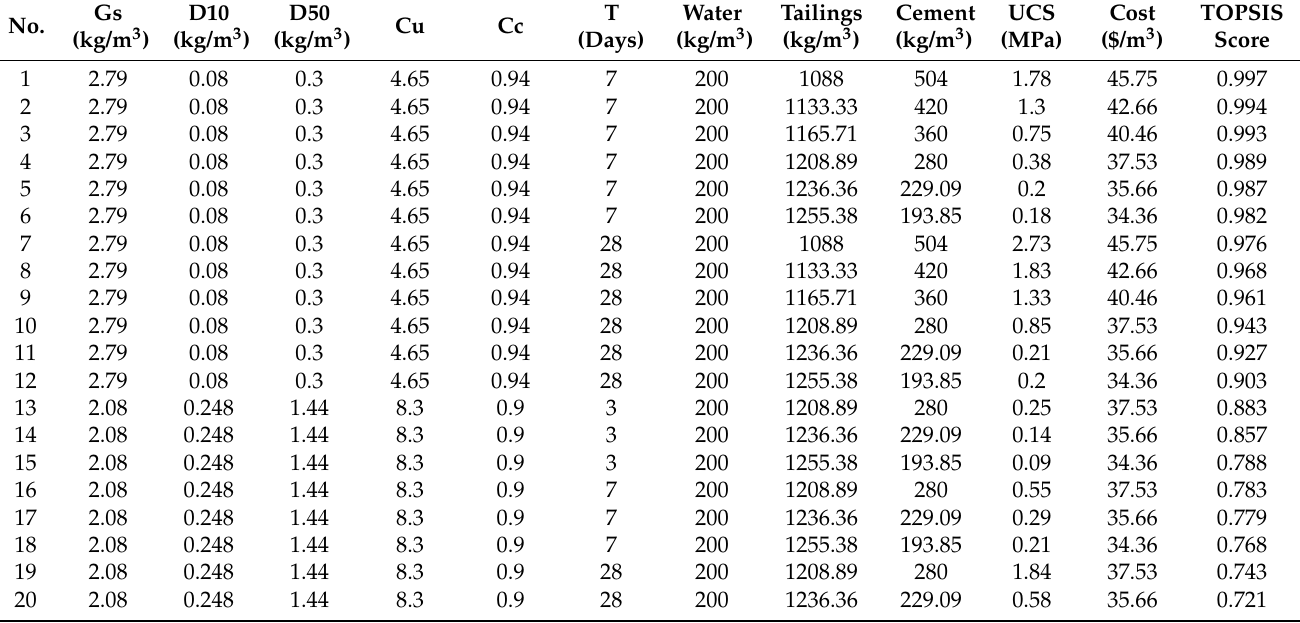
Table 2. TOPSIS score of CPB